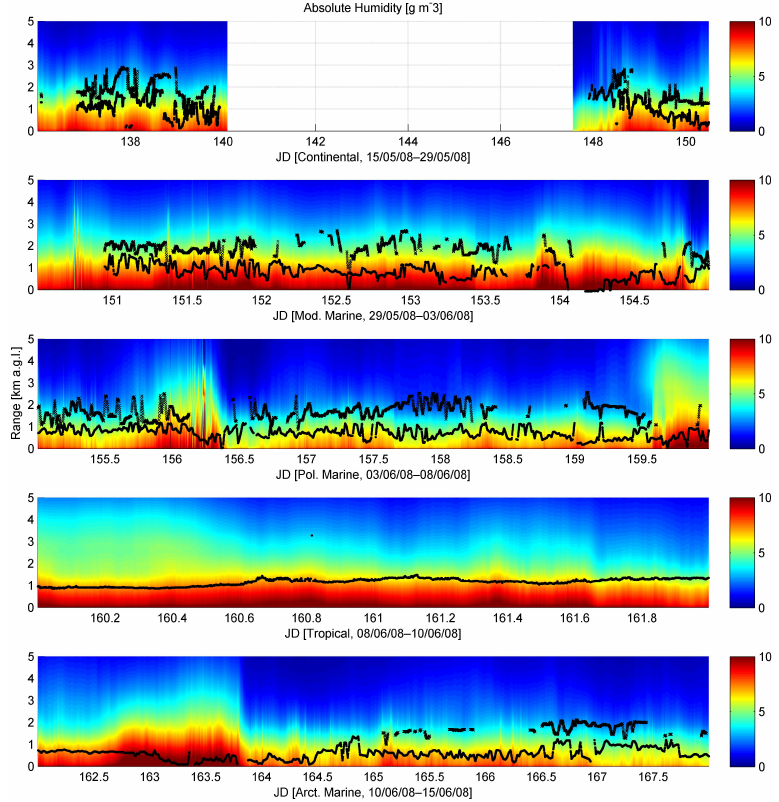
Fig. 3. Boundary Layer stratification observed from the HATPRO microwave profiler absolute humidity product with Lidar-Ceilometer derived layer structure superimposed on the humidity contour plot. The y-axis is kilometers a.g.l. where ground level is approximately 15m a.s.l. The x-axis is Julian Day (JD).